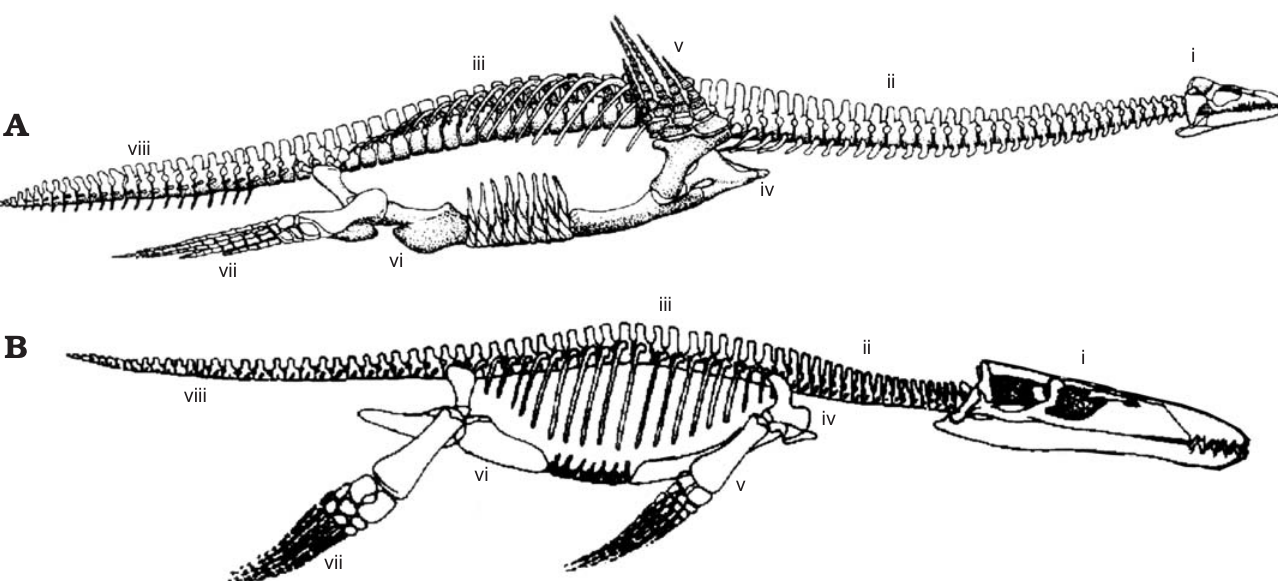
Fig. 1. Two of the three different morphotypes used in Plesiosauria in this analysis, demonstrating the different regions used in skeletal completeness metrics. A . Cryptoclidus , a “plesiosauromorph”. B . Liopleurodon , a “pliosauromorph”. Skeletal regions: i, skull and mandible; ii, cervical vertebrae and ribs; iii, dorsal and sacral vertebrae and ribs; iv, pectoral girdle; v, fore limbs; vi, pelvic girdle; vii, hind limbs; viii, caudal vertebrae and ribs. Outlines modified from O’Keefe (2002). Not to